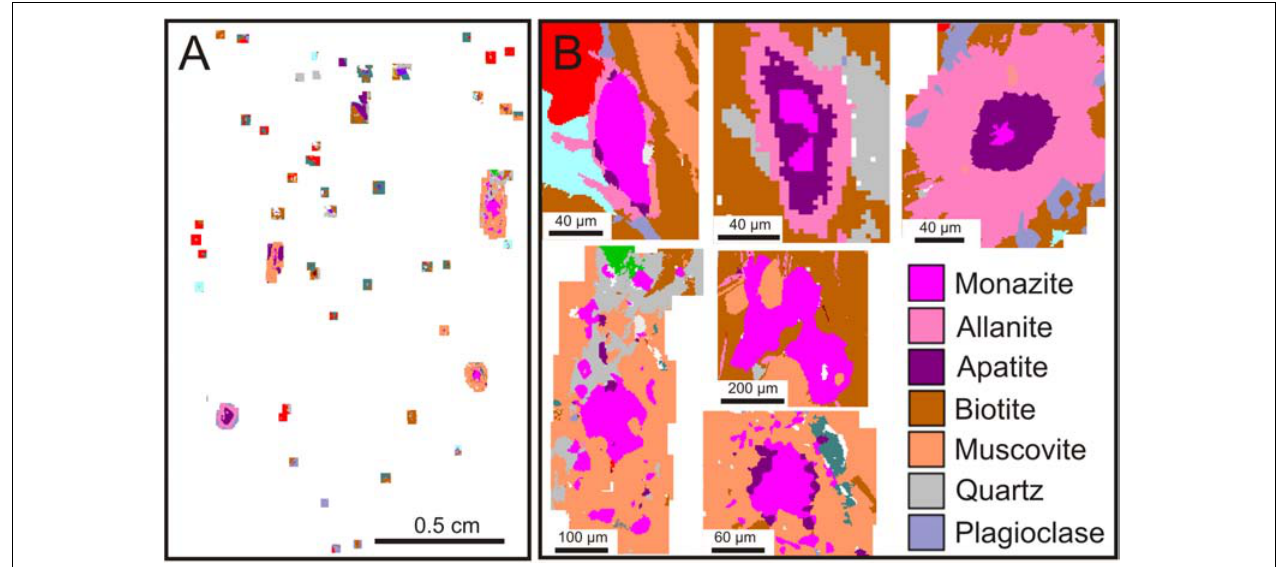
FIGURE 1 | Search for monazite by scanning electron microscopy automated mineralogy methods (e.g., Schulz et al., 2020). (A) Merged frame view of a rare phase search measurement routine applied to a polished thin section. (B) Examples of monazite and its surrounding minerals in a false-colored view as combined from backscattered electron image analysis and energy dispersive spectroscopy spectrum classification by the rare phase search routine. See text for